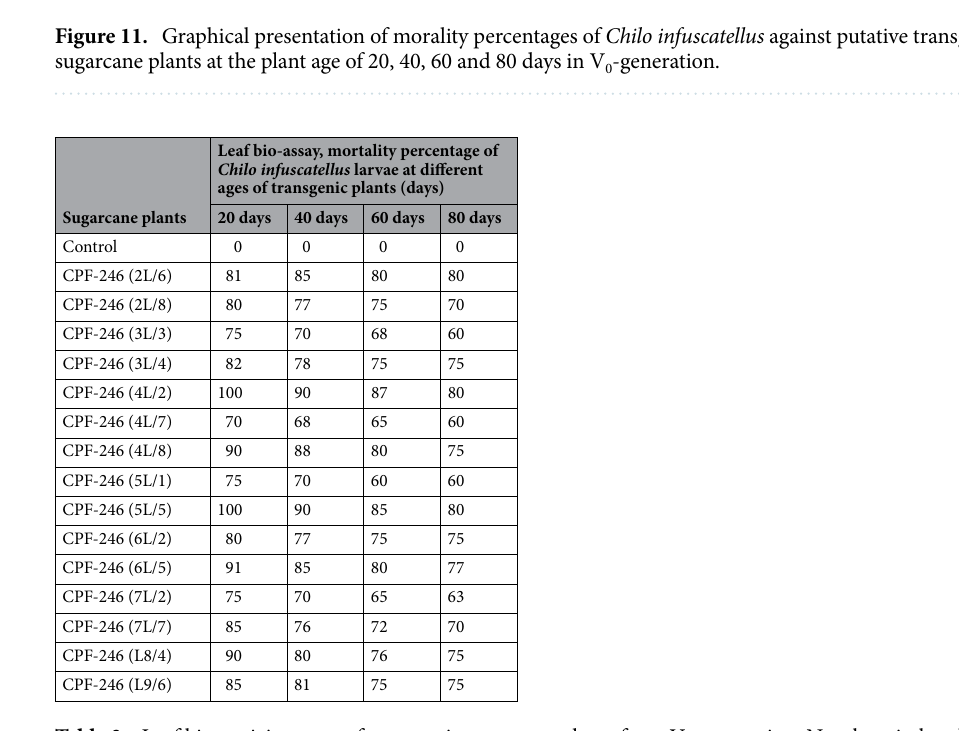
Table 3. Leaf bio-toxicity assay of transgenic sugarcane plants from V 0 -generation. Numbers in brackets are representing the event nos.